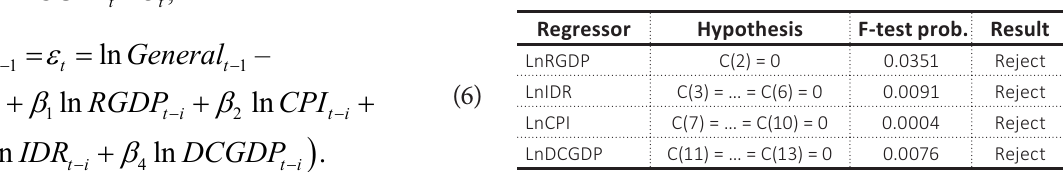
Table 6. Short-run causality based on Wald